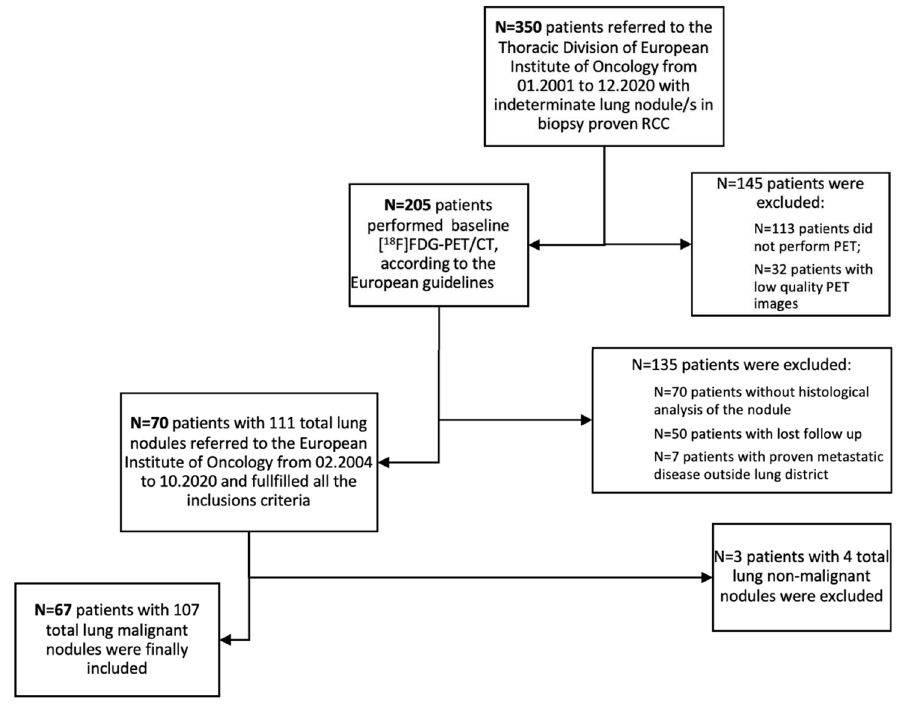
Figure 1. Flowchart for the study population [10]. ceCT was performed in all patients prior to PET imaging. Twenty-five patients (37%) had more than one lung nodule in ce-CT, while forty-two patients (63%) had a solitary lung nodule. All patients underwent lung surgery with histological analysis of the surgical specimens. Fifty-two percent (52%) of the patients (35/67) underwent wedge resection, 43% (29/67) underwent lobectomy, and 4% (3/67) had pneumonectomy. Histological analysis of the 107 malignant nodules revealed lung metastases from RCC in 53% of the patients and primary adenocarcinoma in 33% of them. Other less frequent malignant lesions were squamous carcinoma (7%) and other tumors (7%, such as large cell neuroendocrine carcinoma, large cell undifferentiated carcinoma, lung carcinosarcoma and